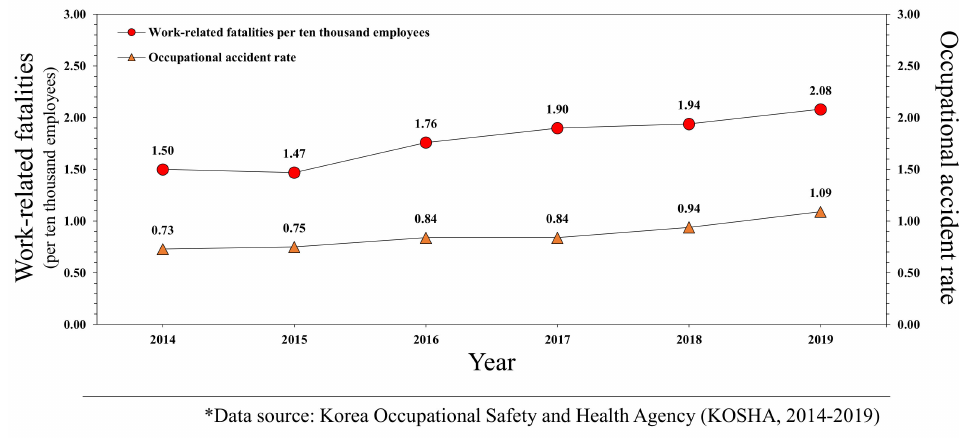
Figure 1. Yearly accident rate and fatality rate in the construction